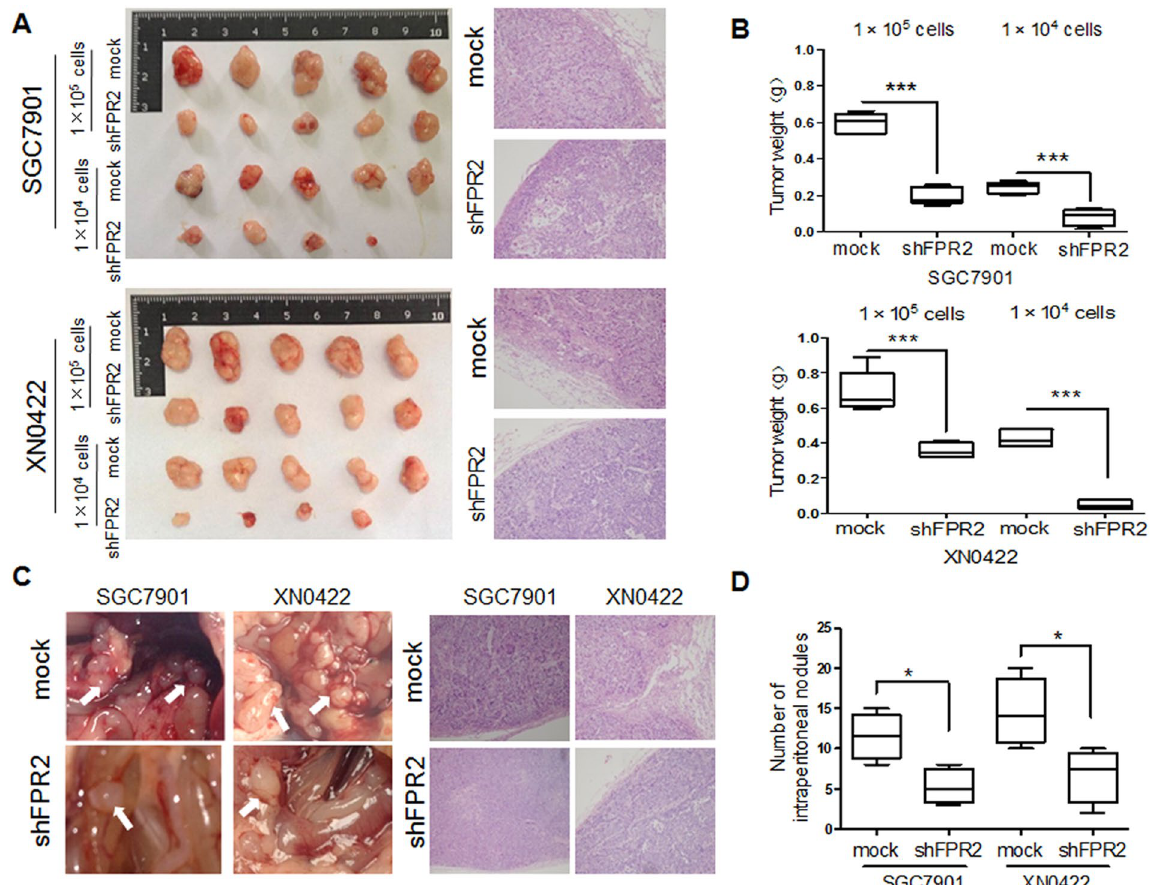
Figure 3. FPR2 promotes tumorigenesis and metastasis of GC cells in vivo . ( A ) Images of xenograft tumors derived from shFPR2 SGC7901 and shXN0422 and their mock cells subcutaneously injected in nude mice at indicated cell number for 5 weeks showed that FPR2-knockdown reduced the tumorigenic abilities of GC cells both in rate of tumor formation and tumor size (left panel). HE staining confirmed the GC pathological characteristics of xenograft tumors (right panel). ( B ) summary graphs showed the weights of tumors derived from FPR2-knockdown SGC7901 (upper) and XN0422 (lower) cells are significantly lighter than those derived from the mock cells. ( C ) Representative images of intraperitoneal metastasis assay showed that metastatic nodules derived from FPR2-knockdown GC cells are far less than those derived from the mock cells (left panel), and HE staining confirms the GC pathological characteristics of the metastatic nodules (right panel). ( D ) Histograms show the difference in number of celiac metastatic nodules derived from FPR2-knockdown GC cells and mock cells (each cell was implanted at 2 × 104 cells/mouse for 4 weeks, n = 5). * p < 0.05, *** p <